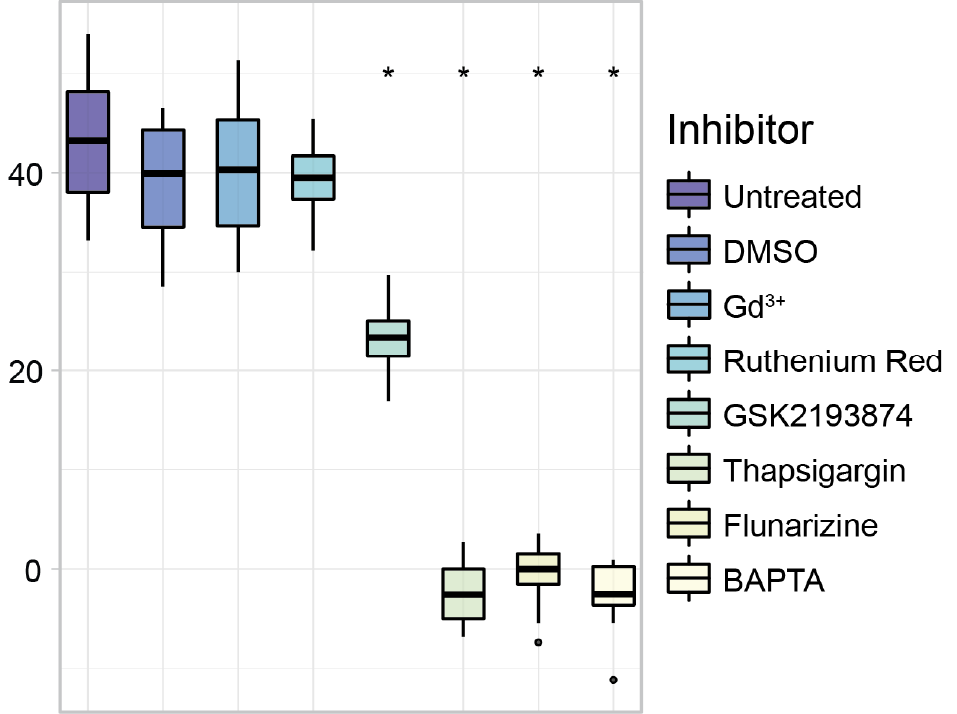
Figure 7. Conversion rates of C28/I2 cells transfected with CaMPARI2 ‐ F391W and treated with selected drugs. Immediately after the parabolic flights, cells were treated for 15 s with 100 µ M histamine and subsequently illuminated for 8 s with 405 nm light. Asterisks indicate significant change compared to Untreated ( p < 0.05 using ANOVA and Tukey posthoc tests). Untreated, DMSO- control, gadolinium chloride, and ruthenium red had no significant effect on the conversion rate of CaMPARI2 ‐ F391W after treatment with histamine. GSK2193874 reduced the conversion efficiency by 50% compared to untreated cells, whereas Thapsigargin and Flunarizine completely inhibited the conversion of CaMARI2 ‐ F391W. The conversion rate of the Pre ‐ Parabola phase as a base conversion of each inhibitor was subtracted from the conversion rates. Asterisks indicate significant differences compared to cells only treated with Histamine (untreated) ( p < 0.05 using ANOVA and Tukey posthoc tests).